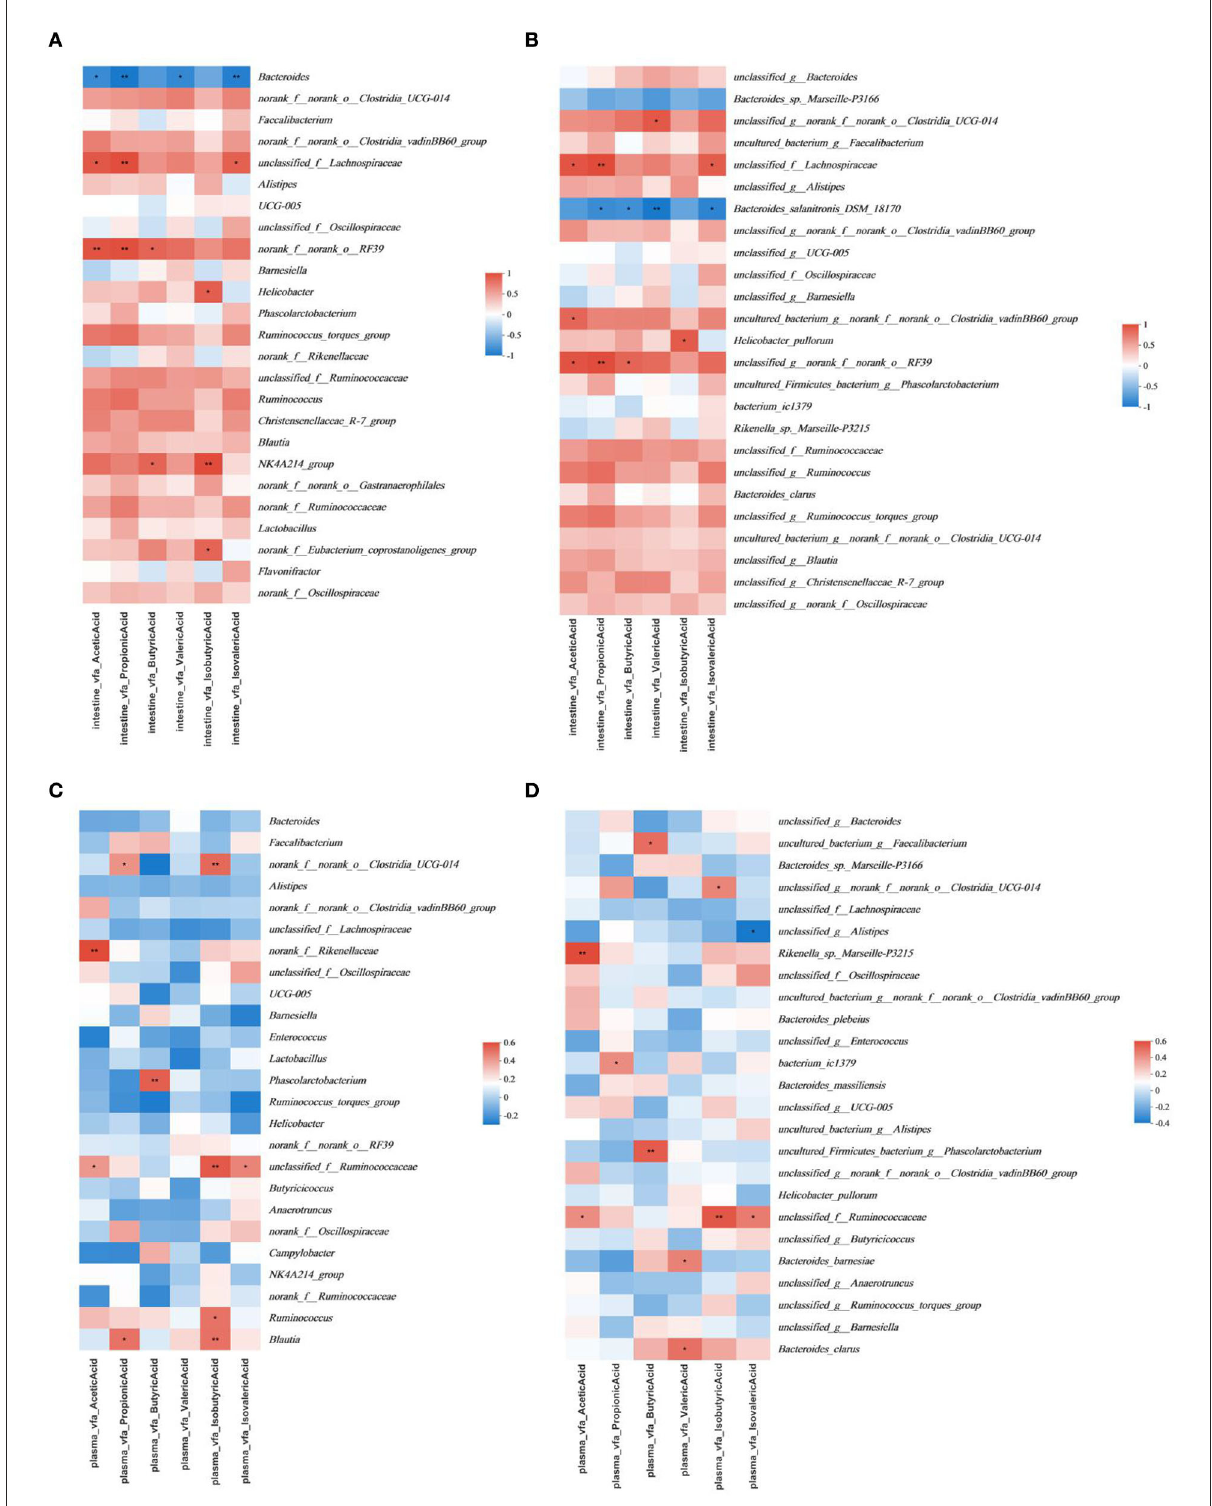
FIGURE7 Significant associations between intestinal and plasma microbial and sample metadata of intestinal SCFAs ( n = 6). (A) Intestinal in the genus; (B) intestinal in species; (C) plasma in the genus; (D) plasma in species. Cells that denote associations are colored (red or blue) and overlaid with asterisks which show statistically significant differences (*, P < 0.05; **, P < 0.01; ***, P < 0.001). o__: order; f__: family; g__: genus. T0: fed diets based on SBM as the only protein source; T1, T2, T3, T4, T5: 1, 2, 3, 4, and 5% of CAP were